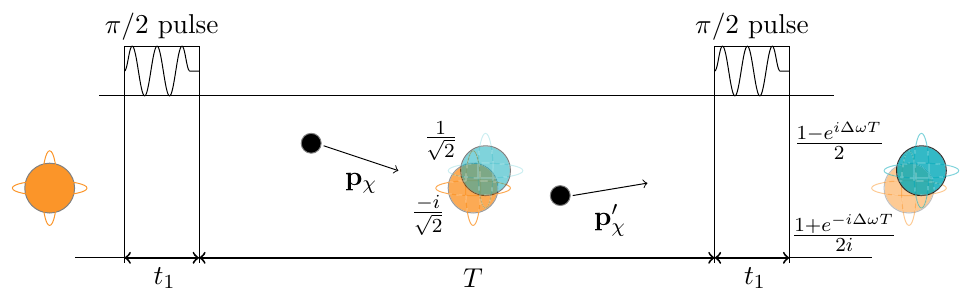
Figure 3 . Scheme for the Ramsey sequence. The horizontal axis represents time. In orange (blue) we depict the ground (excited) state with DM particles of momentum p χ . See main text for